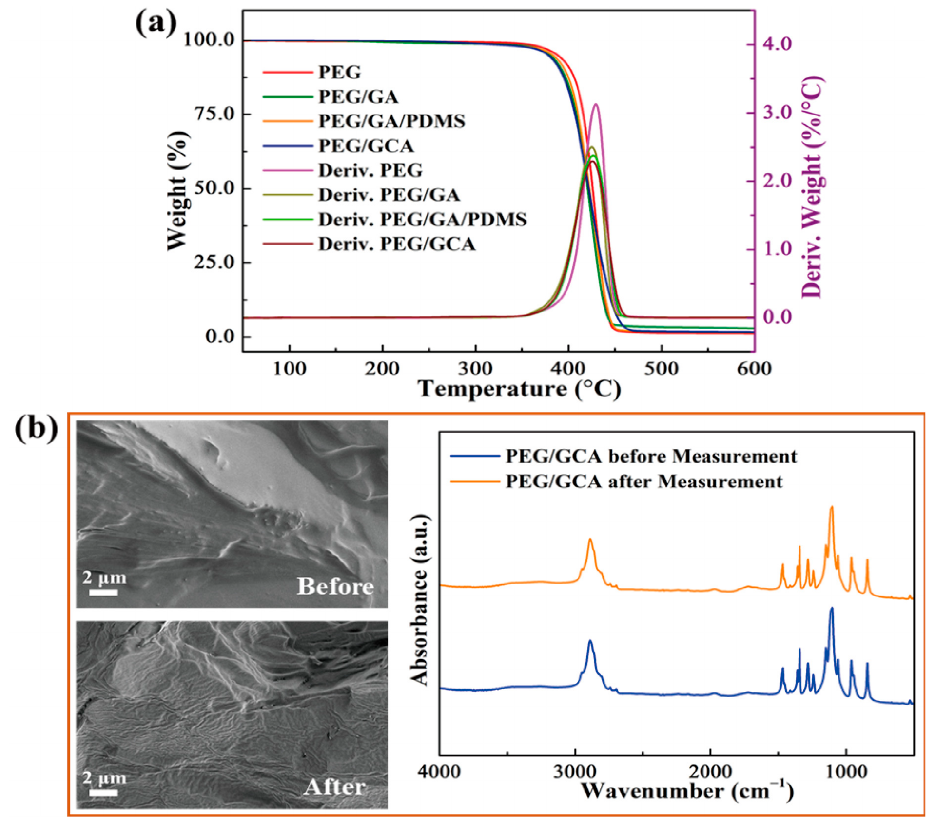
Figure 8. ( a ) TGA peaks of the pure PEG and PEG composites. ( b ) SEM and FTIR results of the PEG/GCA composite after TGA